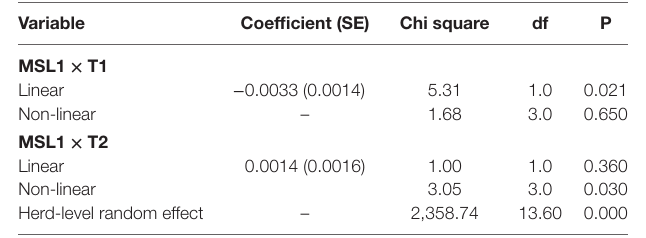
TaBle 2 | Risk factors for culling, sales and deaths in New Zealand dairy goat herds, 2000–2009.